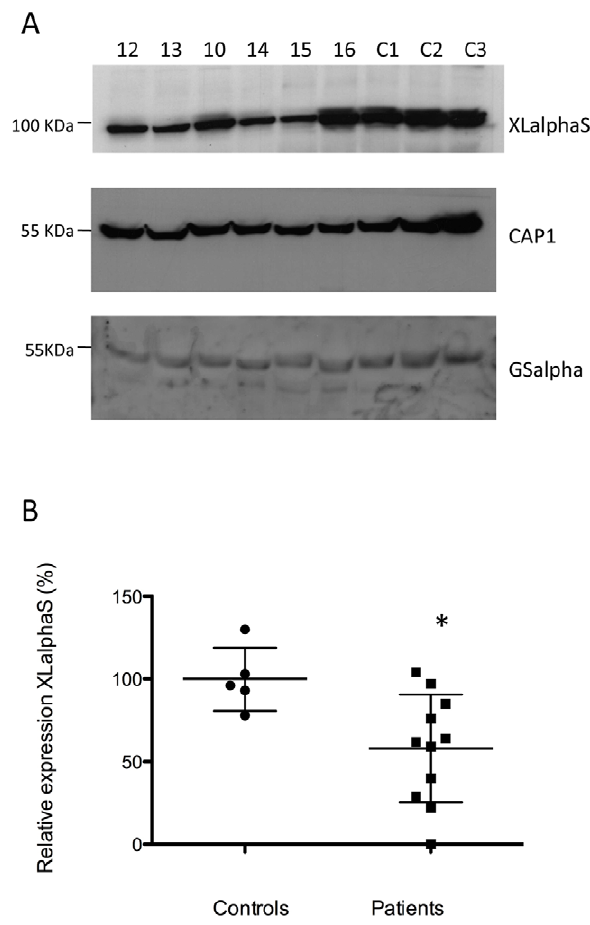
Figure 3. XLalphaS and Gsalpha expression in platelets from AHO-like patients. XLalphaS, CAP1 and Gsalpha expression in AHO- like platelets. A. Immunoblot analysis of XLalphas, CAP1 and Gsalpha protein in platelet lysates from XL hypermethylated AHO-like patients 12, 13, 10, 14, 15, 16 and 3 controls and B. correspondent densitometric scanning of XLalphaS protein in platelet lysates from AHO-like patients with XL hypermethylation (patients 6 to 16) and 5 controls (Controls). Results are expressed as percentage of controls (taken as 100%). Mean as well as SD are depicted as black horizontal and vertical lines, respectively. *, p value , 0.05, two-tailed unpaired T-test.